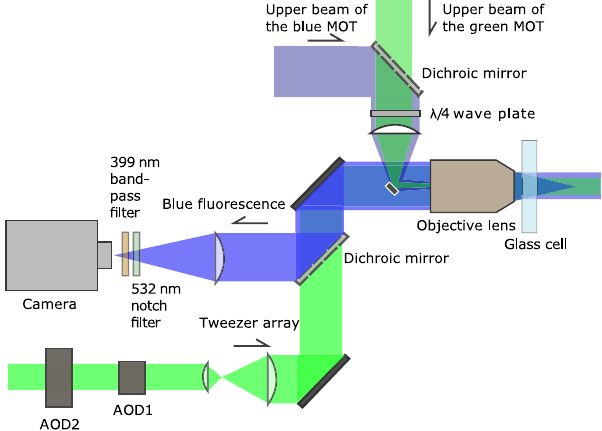
FIG. 7. Optics around the objective lens. The 399 and 556 nm laser beams for the MOTs are focused to the back focal plane of the objective lens and reflected by a mirror, small enough not to degrade the quality of either the tweezers or the